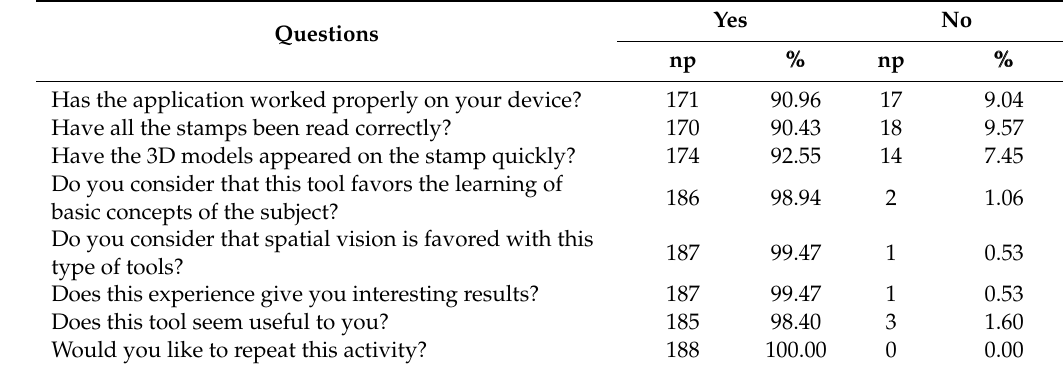
Table 2. Results of the survey conducted by the students.